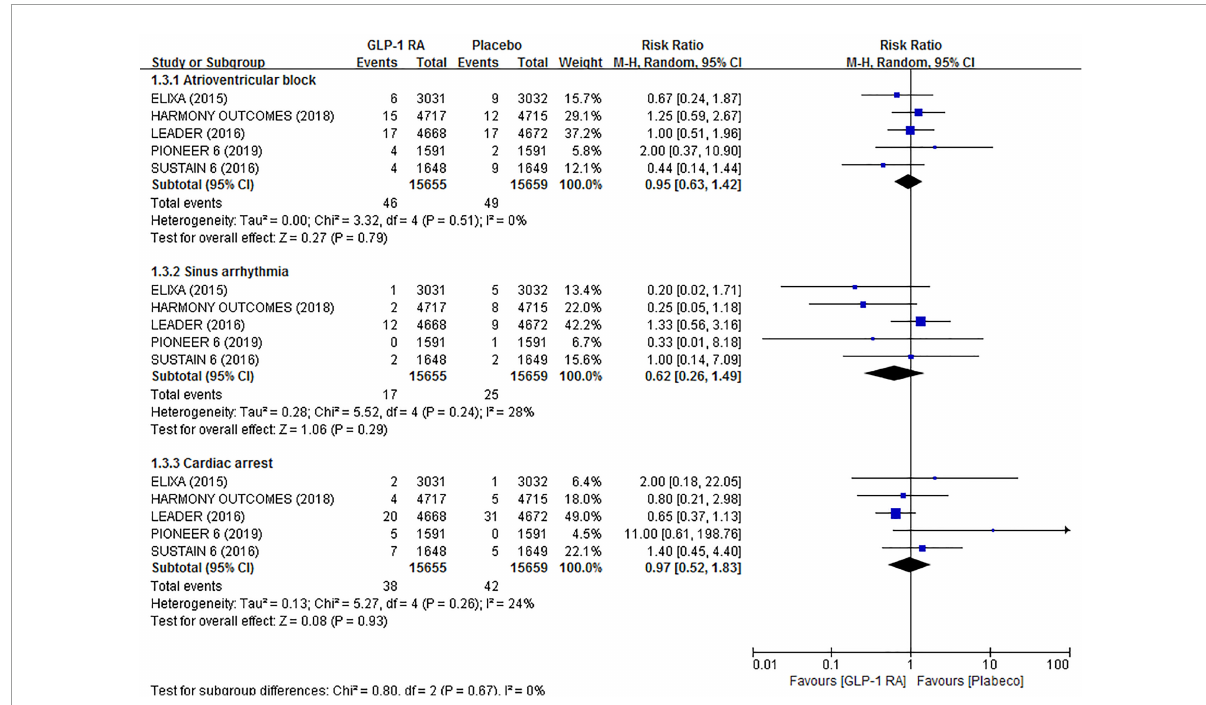
FIGURE4 Forest plot of the association between GLP-1RAs and the risk of other arrhythmias compared with plabeco.